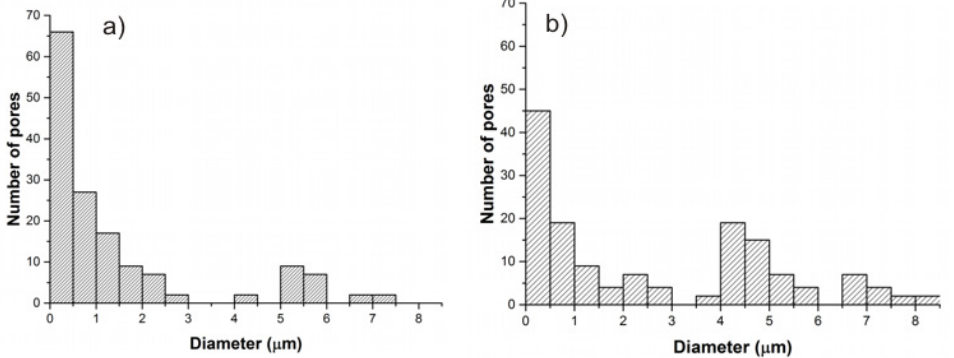
Figure 3 . Pore size distribution of ( a ) BC, and ( b ) DABC samples. Figure 3. Pore size distribution of ( a ) BC, and ( b ) DABC